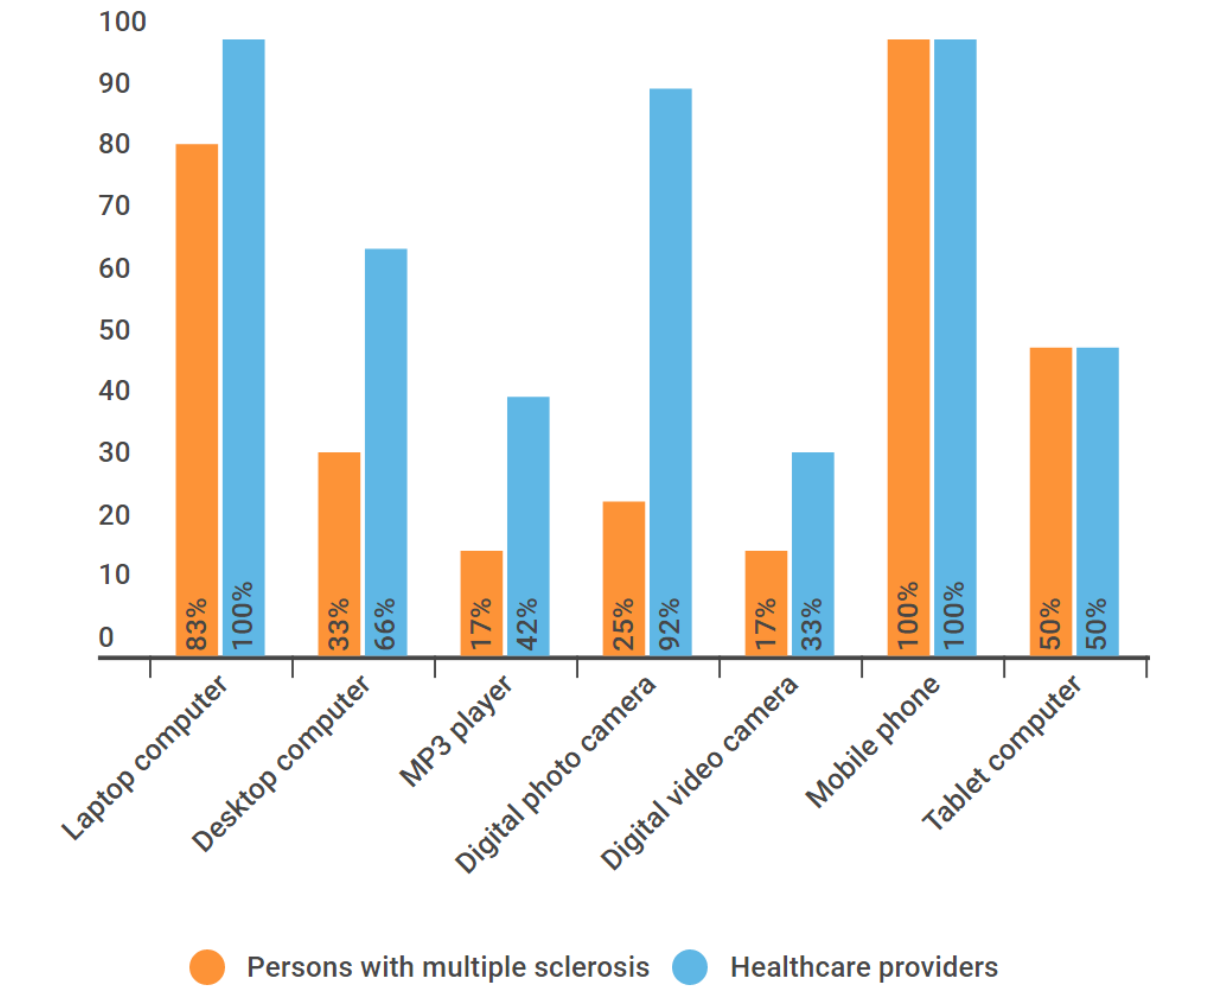
Figure 1. Information and communications technologies